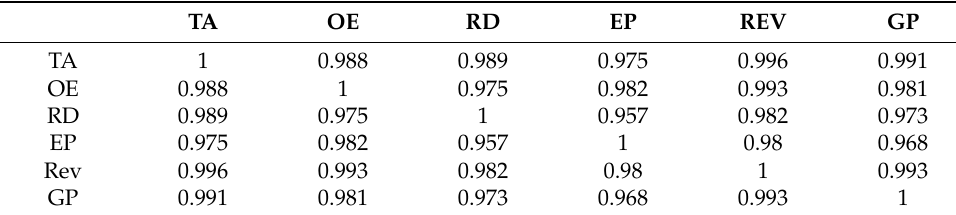
Table 4. Average of Pearson correlation coefficients of inputs and outputs from 2015 to 2019.